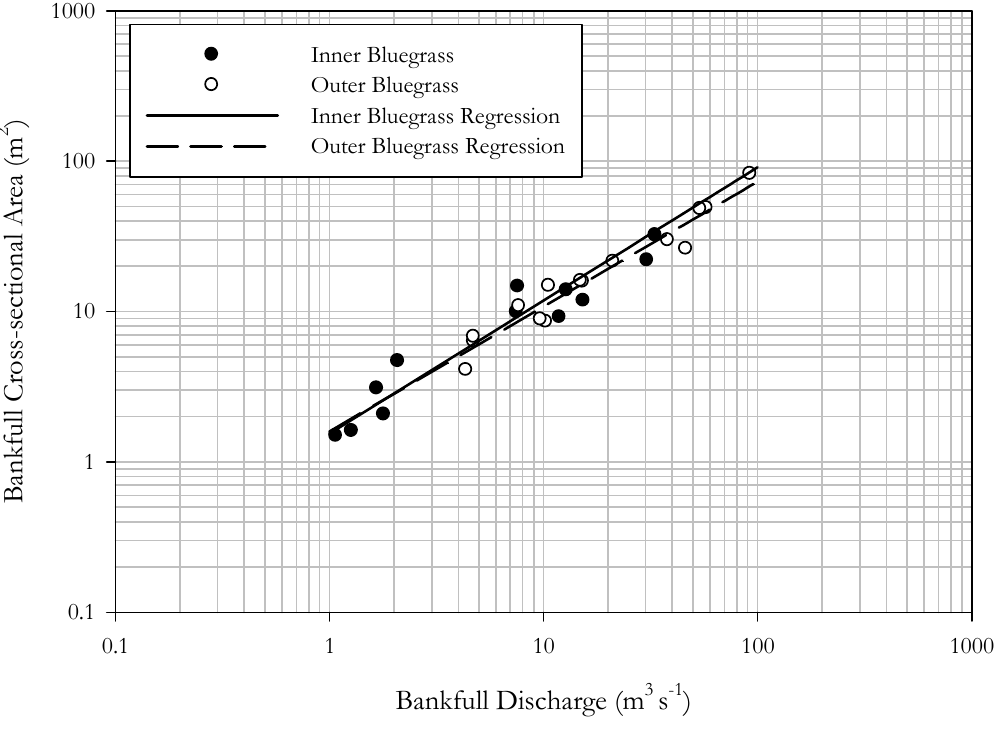
Figure 4. Bankfull cross-sectional area vs . bankfull discharge for the Inner Bluegrass and Outer Bluegrass regions.